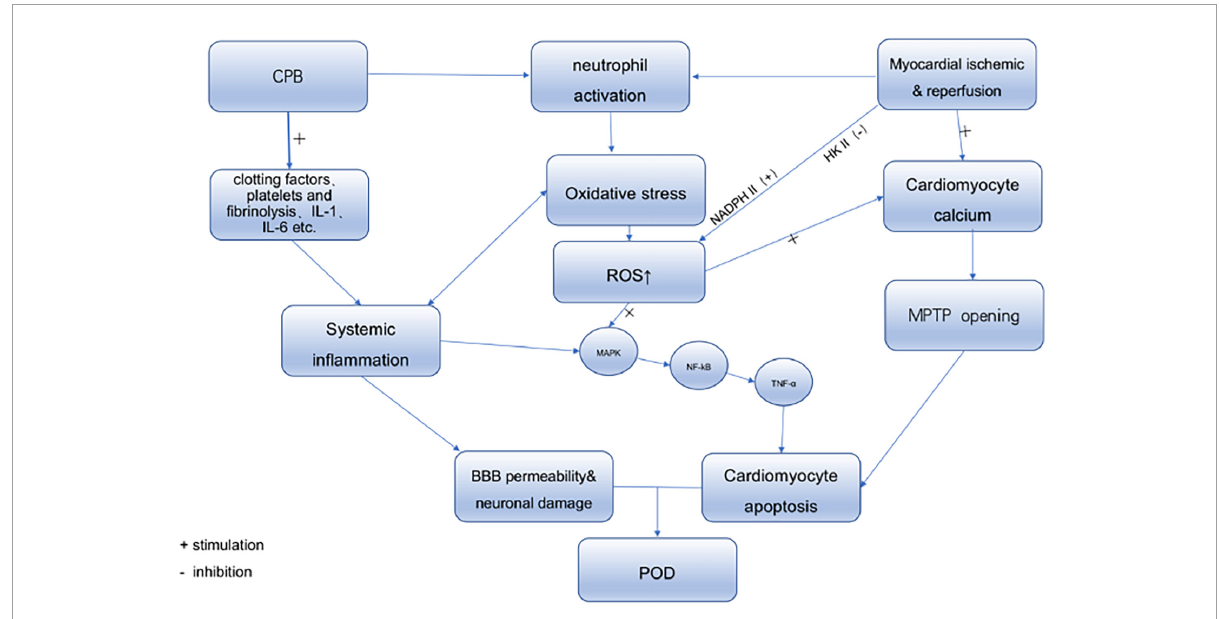
FIGURE1 The source of inflammatory response in cardiac surgery and its effect on POD.